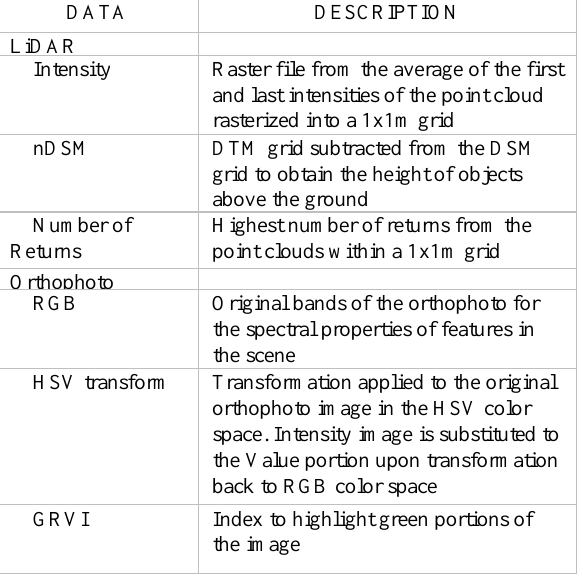
Table 1. Description of the layers used in the study